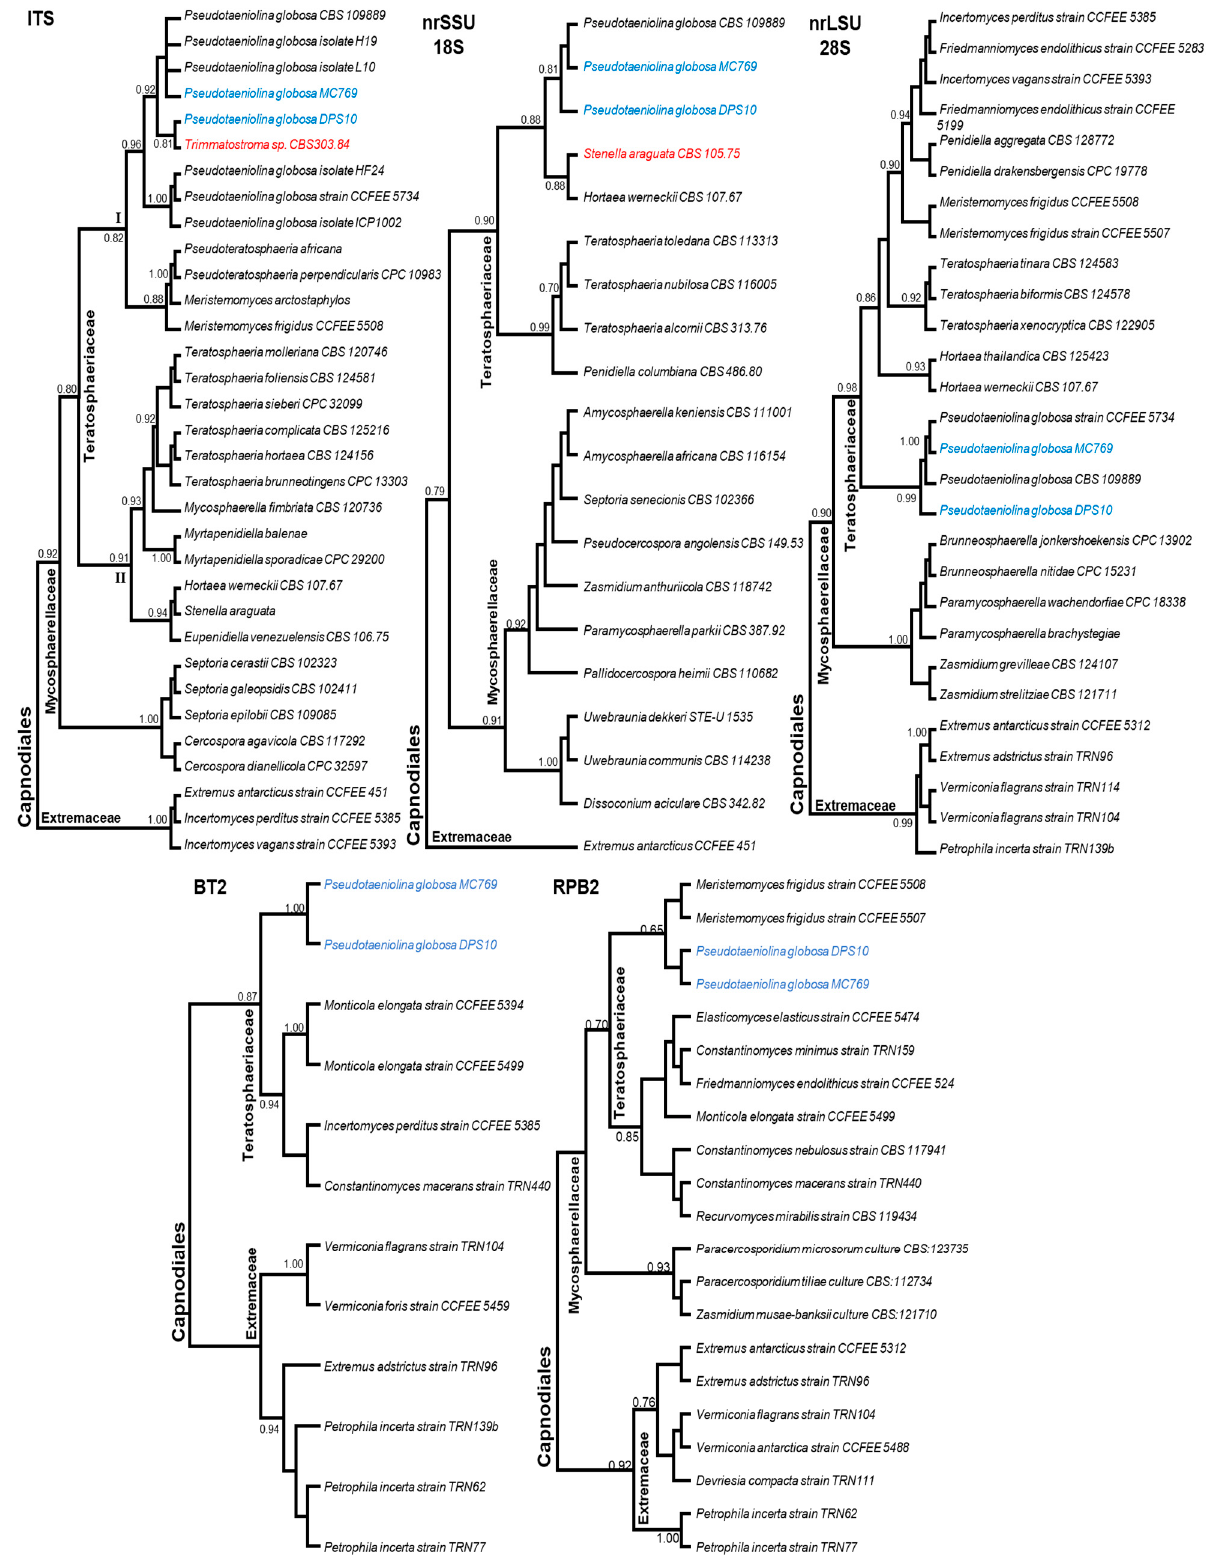
Figure 8. Maximum likelihood-based phylogenetic trees for top similar accessions of Extremaceae, Mycosphaerellaceae, and Teratosphaeriaceae families (order Capnodiales) from GenBank NCBI database to ITS, nrSSU 18S, nrLSU 28S, BT2 and RPB2 sequences of Pseudotaeniolina globosa isolates (MC769 and DPS10 written in blue color). Trees are rooted by the Extremaceae clade/species; mistakenly labeled/grouped accessions are written in red.